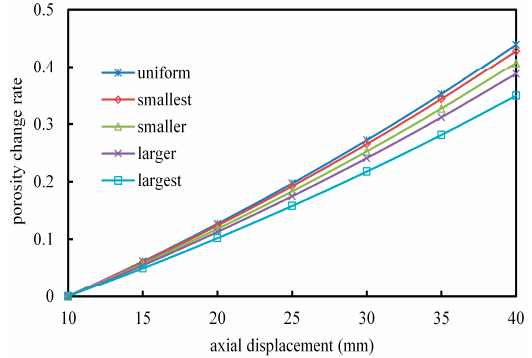
Figure 9. Porosity change rate of each axial displacement.